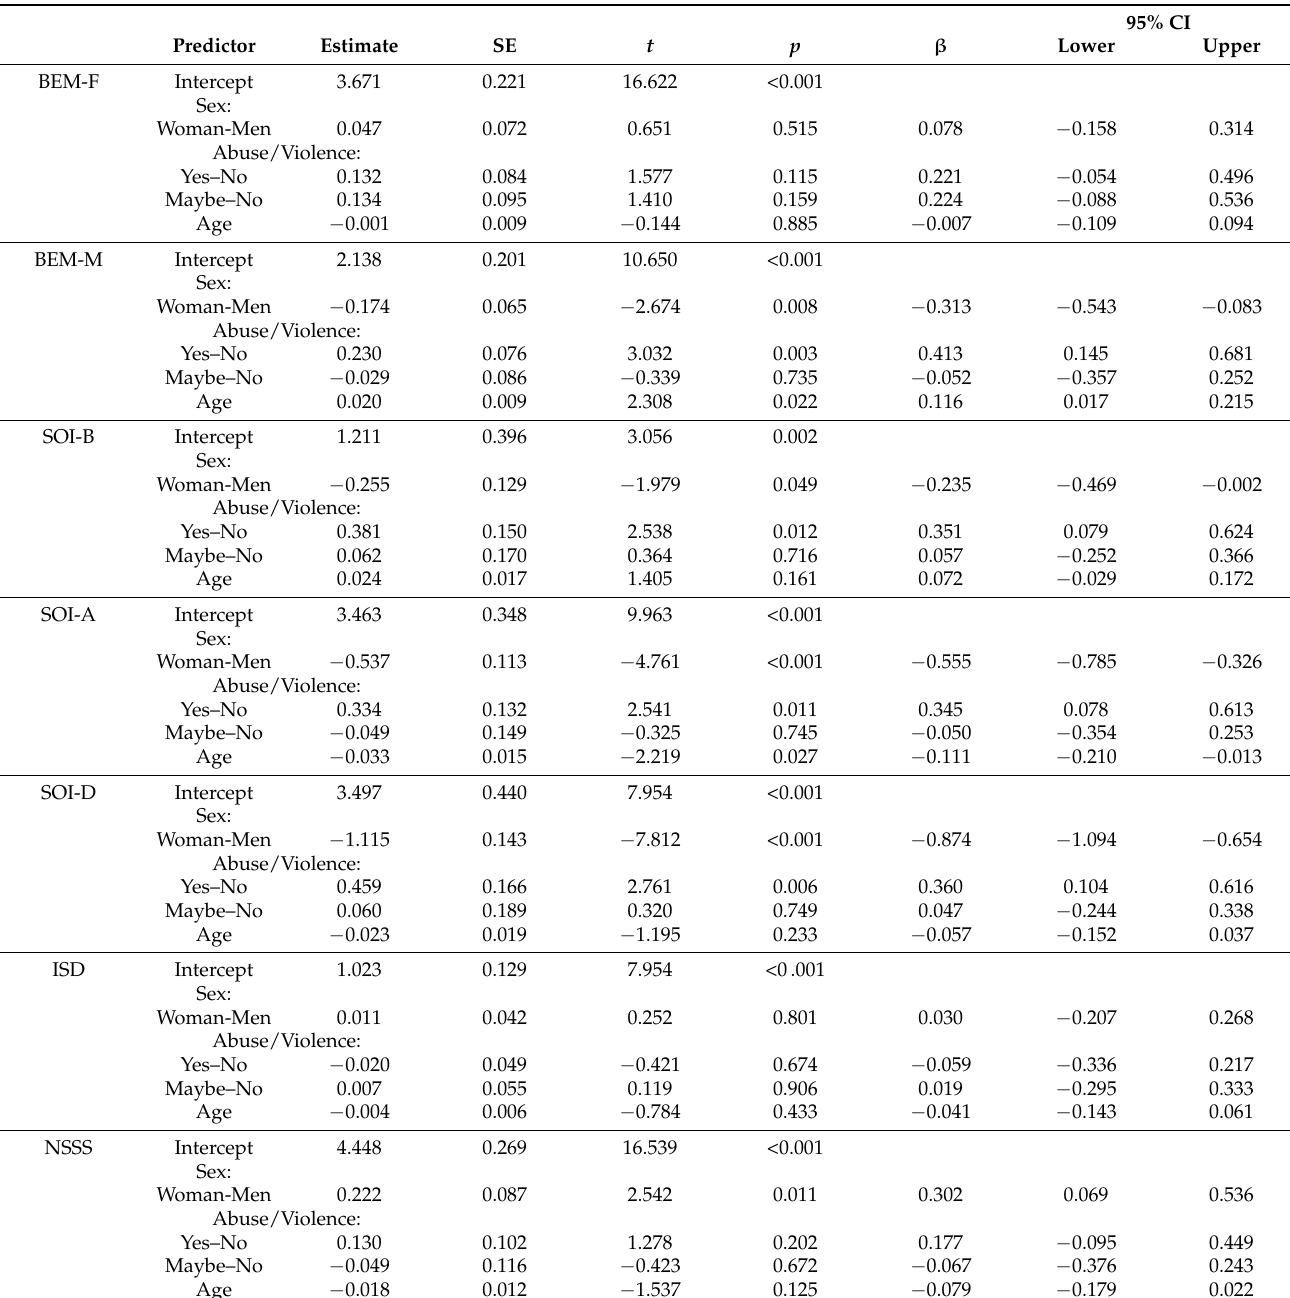
Table 1. Predictors for multiple